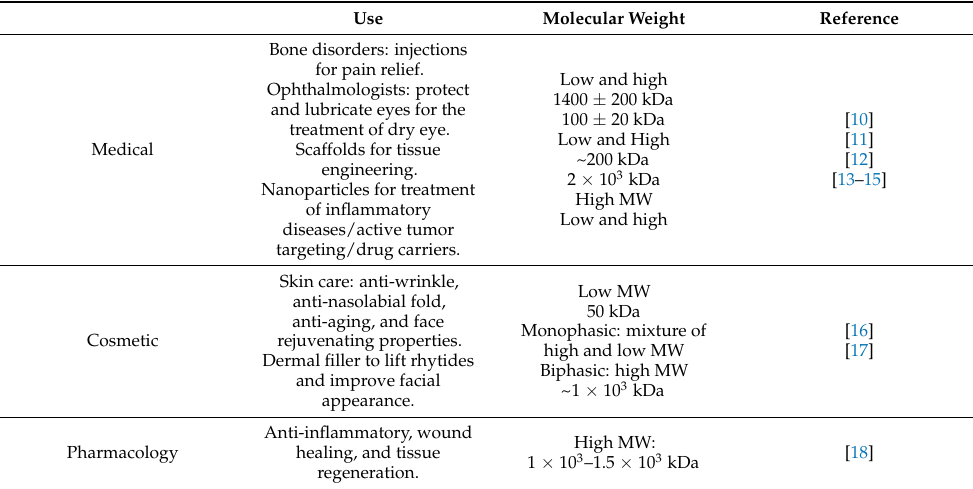
Table 2. Applications and required molecular weights of HA. Use Molecular Weight Reference Bone disorders: injections for pain relief. Ophthalmologists: protect and lubricate eyes for the Medical